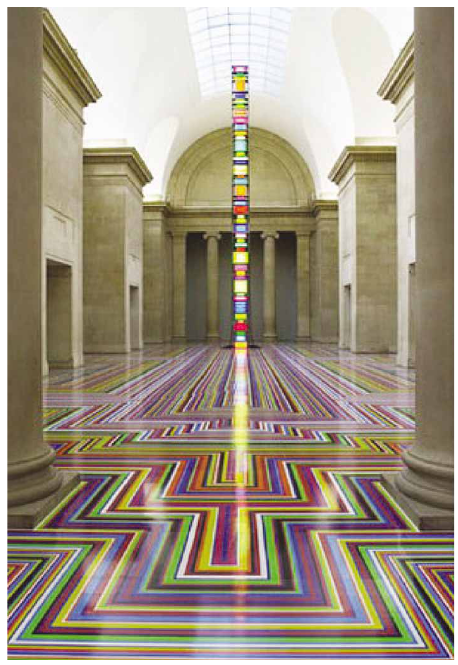
Fig. 3. Jim Lambie. Touch Zobop , Duveen Galleries, Tate Britain,